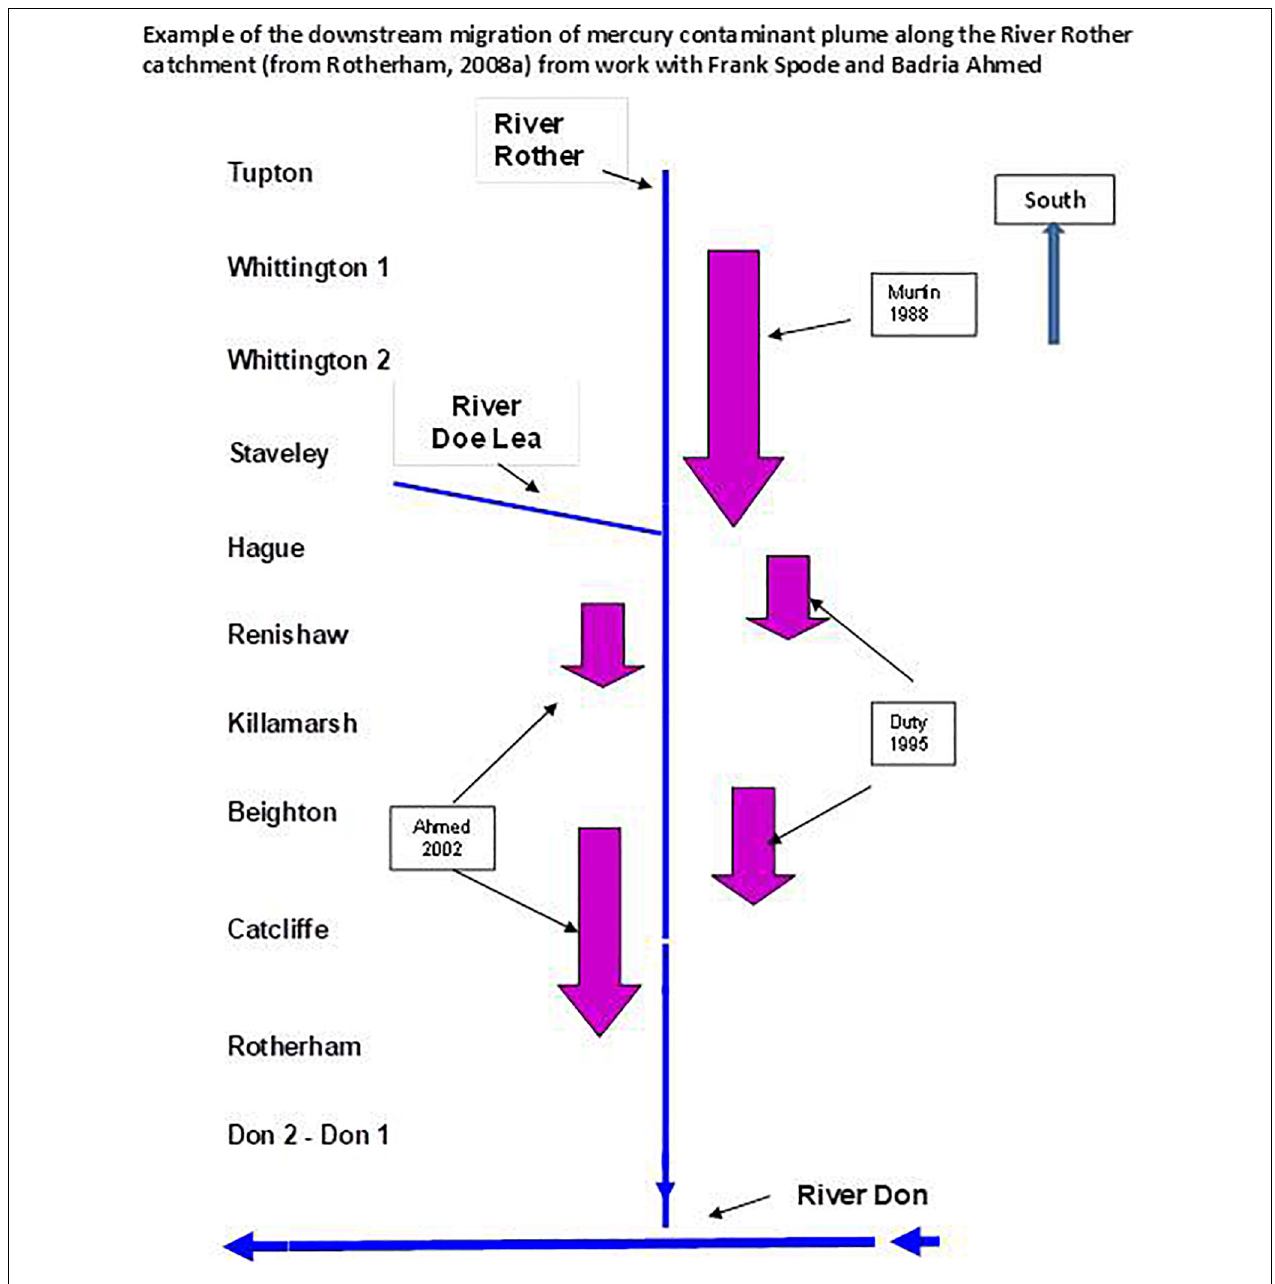
FIGURE 6 | Migration of mercury contamination on the River